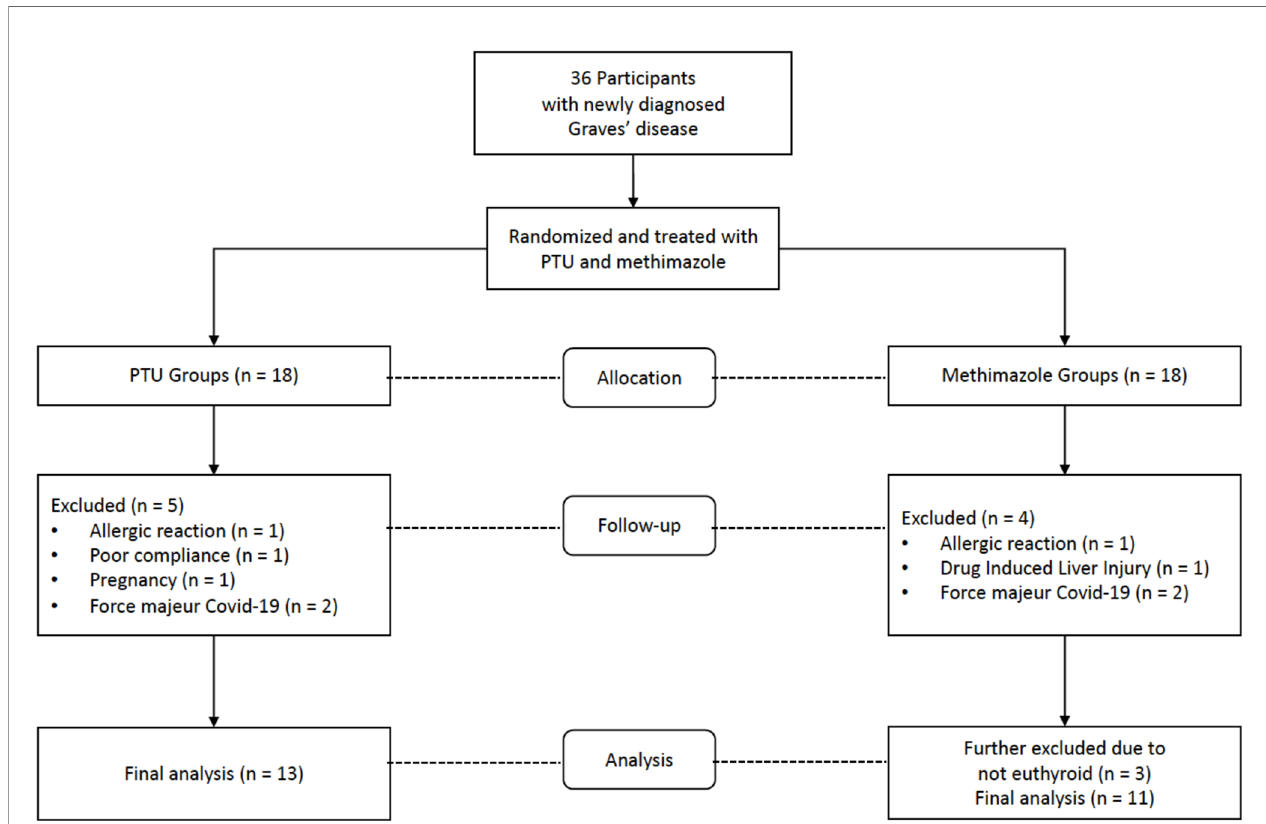
FIGURE 1 | Consort fl ow diagram of study